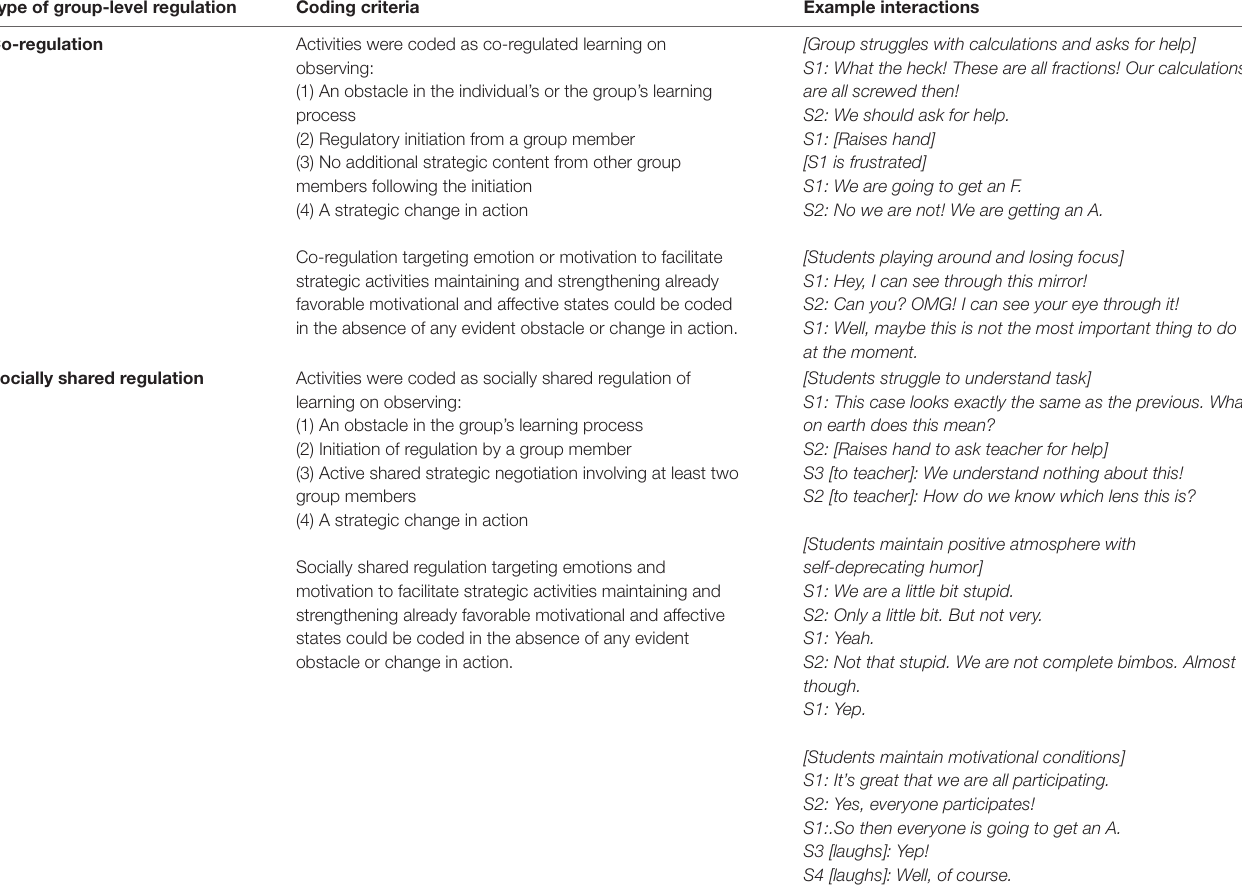
TABLE 2 | Coding criteria and example interactions of co- and socially shared regulation of learning (Törmänen et al., 2022). Type of group-level regulation Coding criteria Example